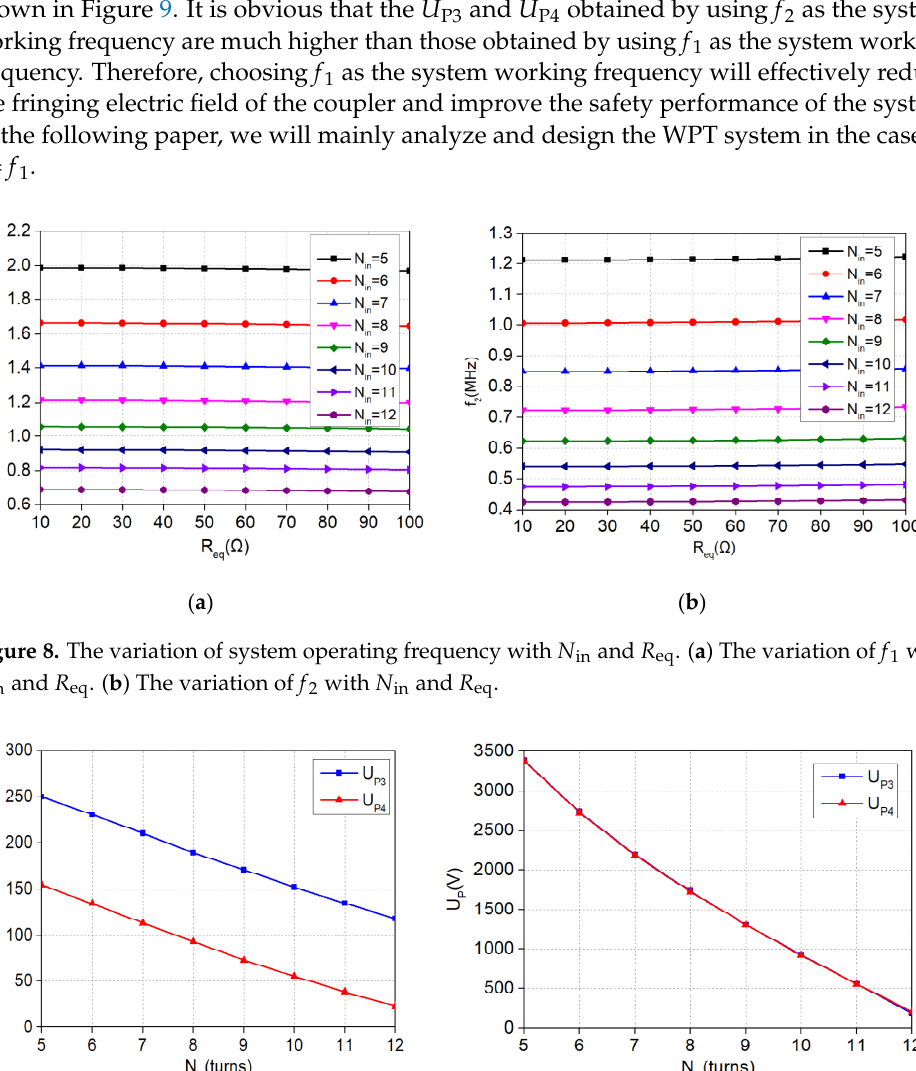
Figure 9. Variation curve of the voltage to ground of P 3 and P 4 with N in . ( a ) f = f 1 . ( b ) f = f 2